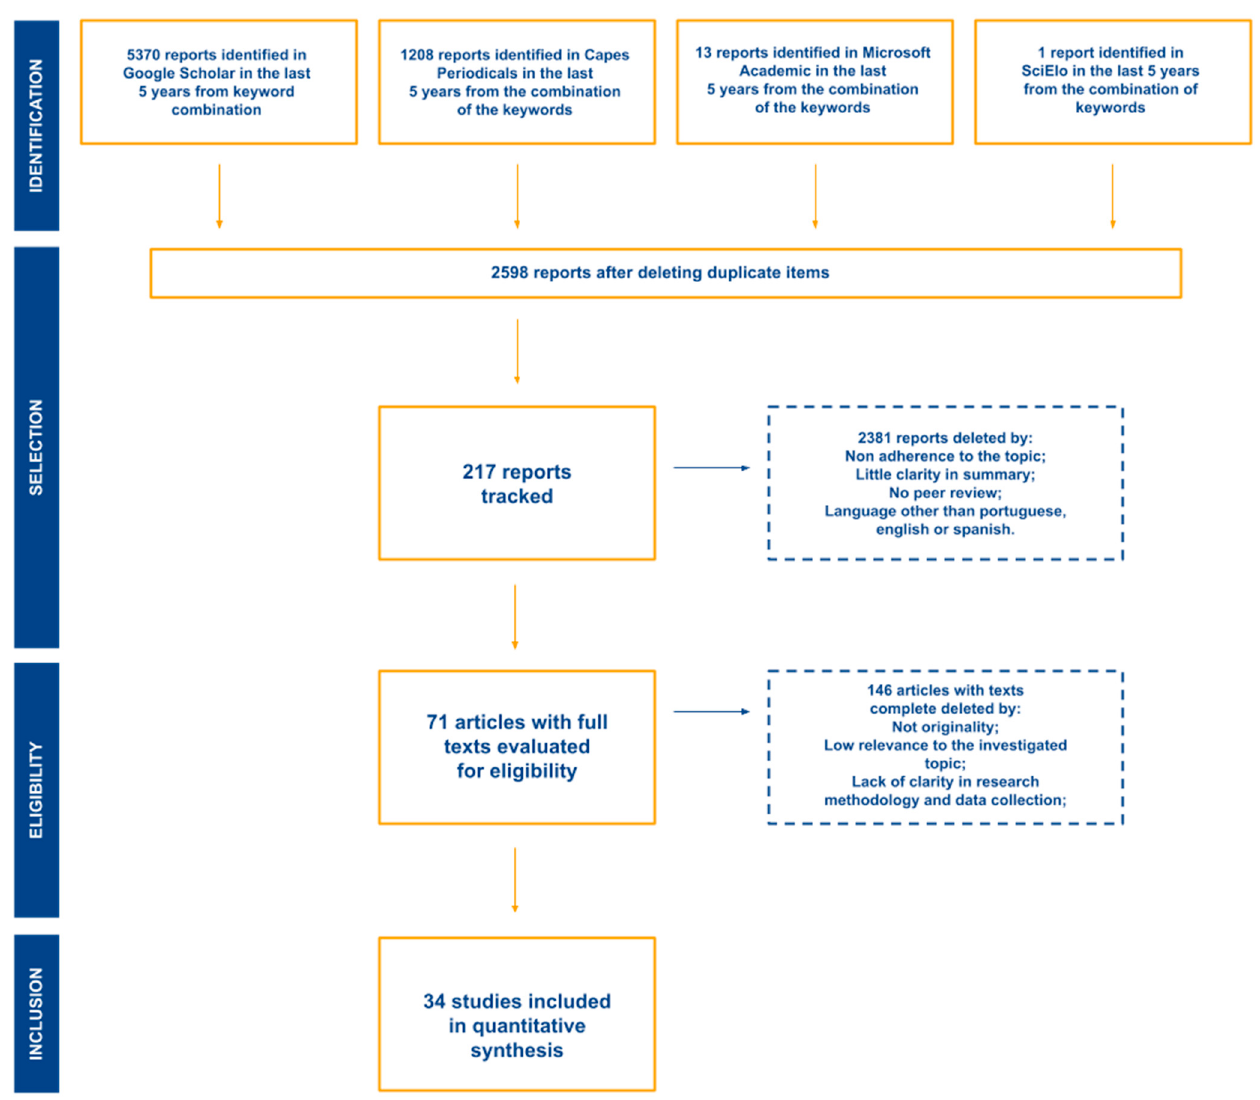
Figure 1. Summary of bibliographic research using the PRISMA flowchart.